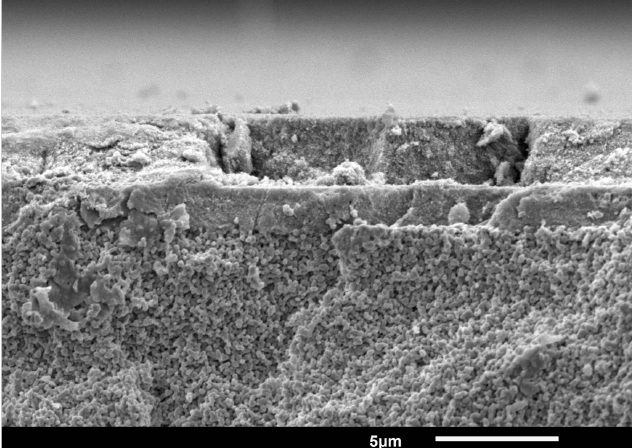
Figure A1. SEM cross-sectional picture of titania and γ -alumina layers on an α -alumina